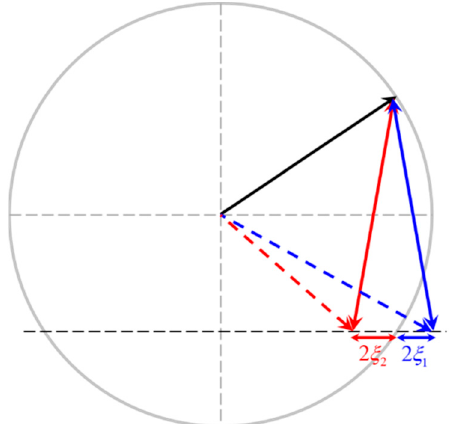
Figure A2. Wavevector representation illustrating the phase mismatching of an incident wave (in black) propagating close to the Bragg condition reflected to two different directions along the directions illustrated by the dashed lines in red and blue.